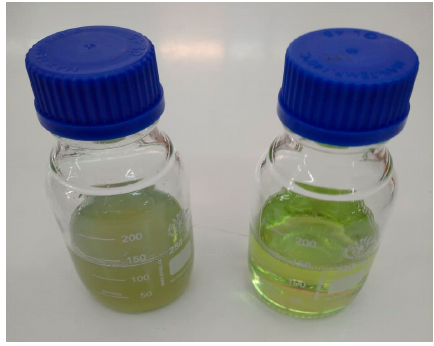
Figure 1. The NF samples shortly after their synthesis: sNF left; iNF right.